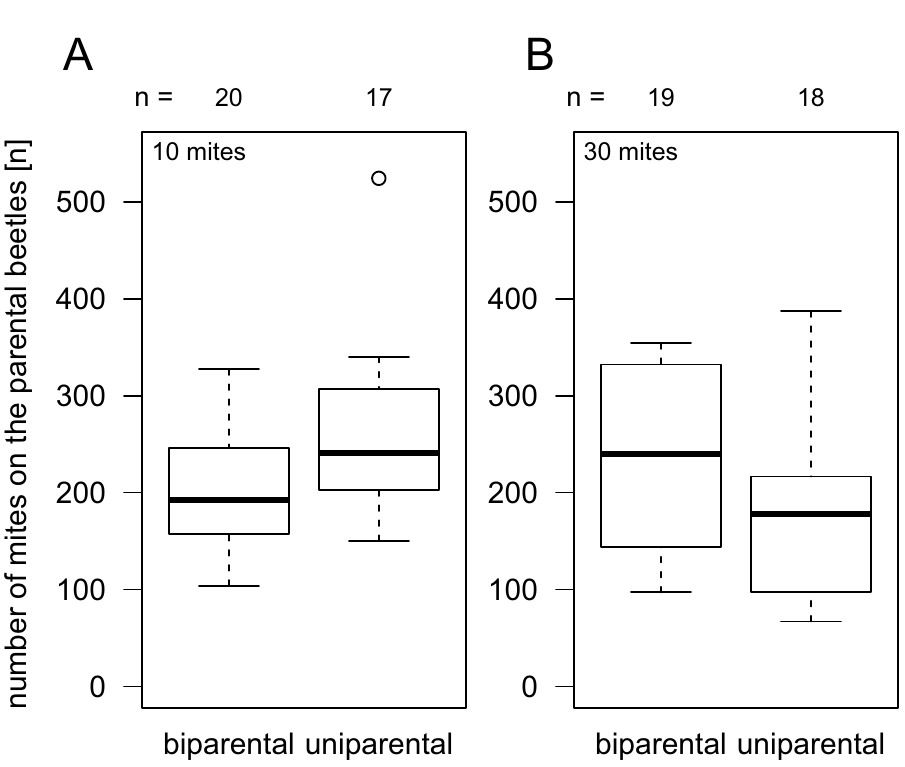
Fig 2. The number of mites that left the carcasses on the parental beetles was not affected by the number of caring parents. (p = 0.39), neither at an initial mite dose of 10 (A), nor 30 (B) mites (interaction mite dose x parent number p = 0.44). More mites developed when the initial mite dose was larger (p < 0.001). Boxplots depict median (thick line), interquartile range (box), minimum and maximum. Numbers are sample